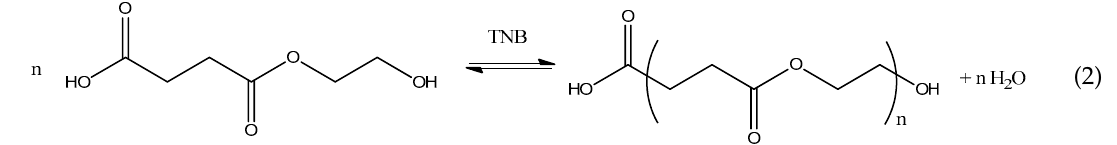
Table 1. Experimental reaction conditions for the synthesis of bS polyol. T (°C): process temperature;